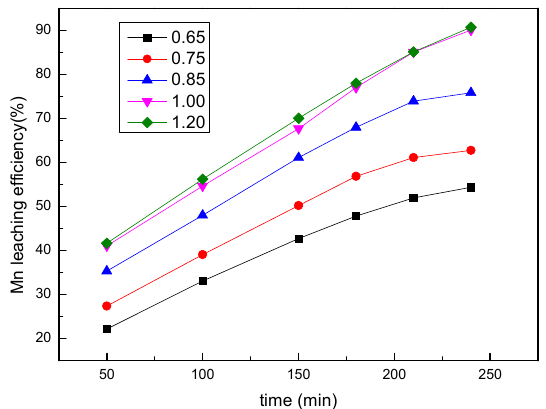
Figure 5. The effect of the sulfuric acid concentration on the manganese leaching efficiency.